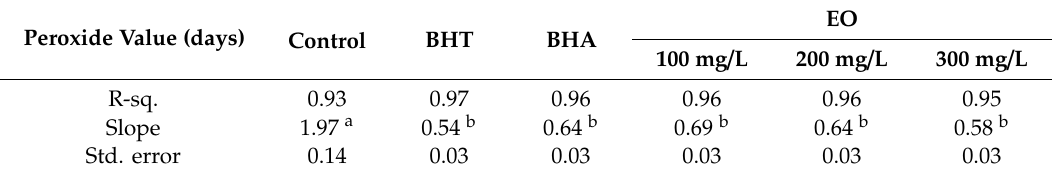
Table 3. Linear regression analysis of peroxide values with incubation period as independent variable.